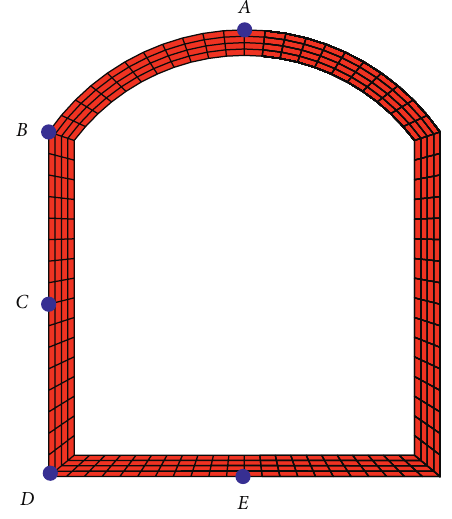
Figure 9: Positions of the monitoring